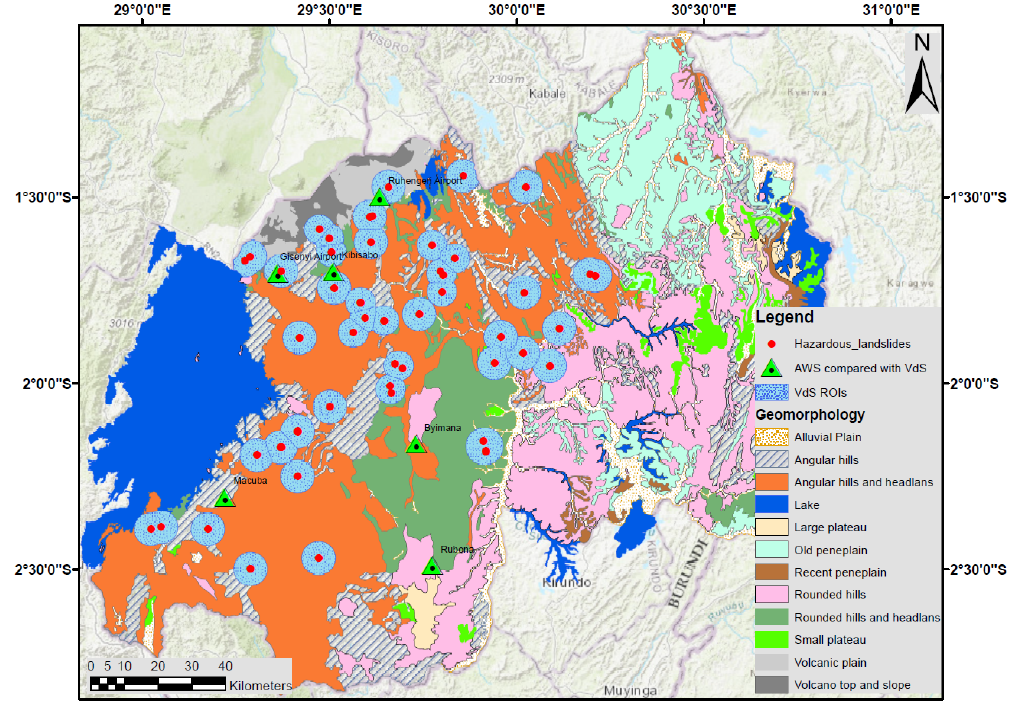
Figure 2. Geomorphology of Rwanda, landslide representative AWSs (automated weather stations) with soil moisture sensors, landslides in red dots and 5km buffer zones indicating the research area of interest (ROI) for areal soil moisture